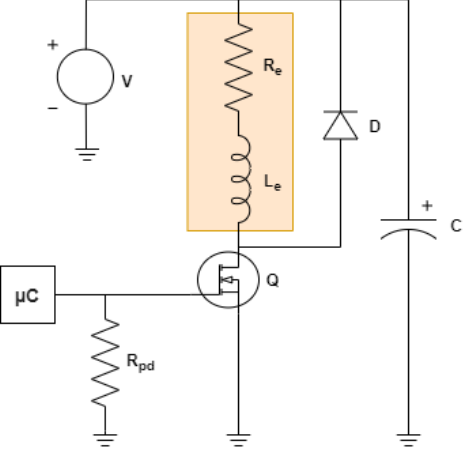
Figure 2. Driver